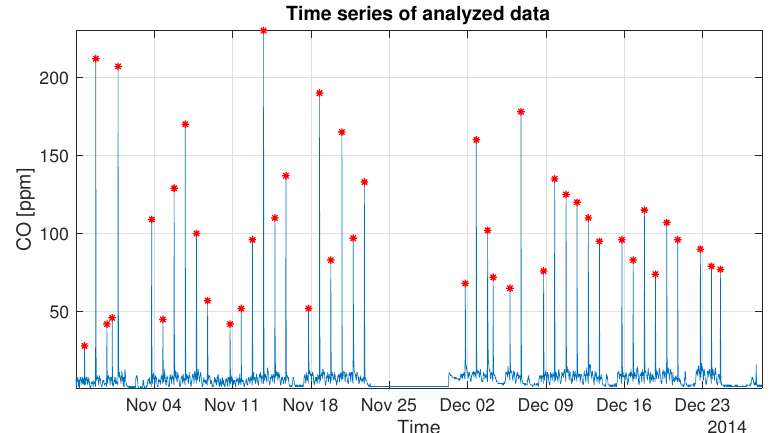
Figure 3. Raw signal describing carbon monoxide variation.